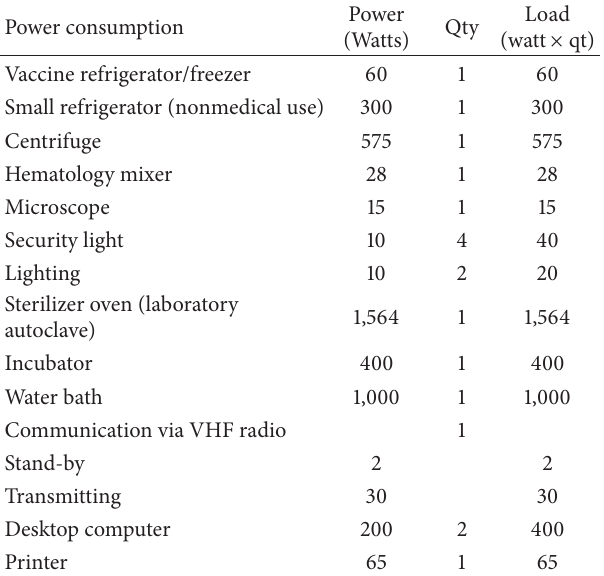
Table 1: Power consumption rating.